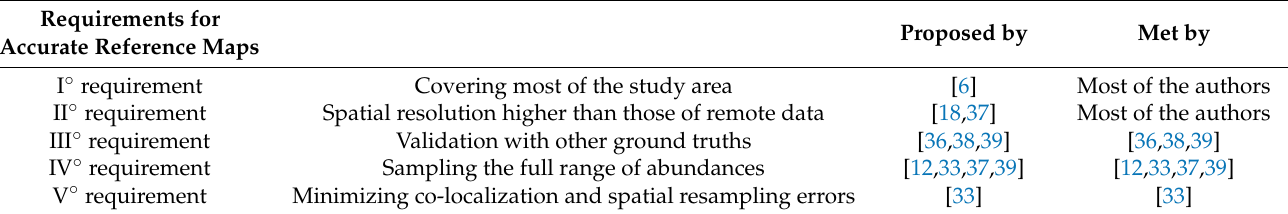
Table 1. Requirements for accurate reference